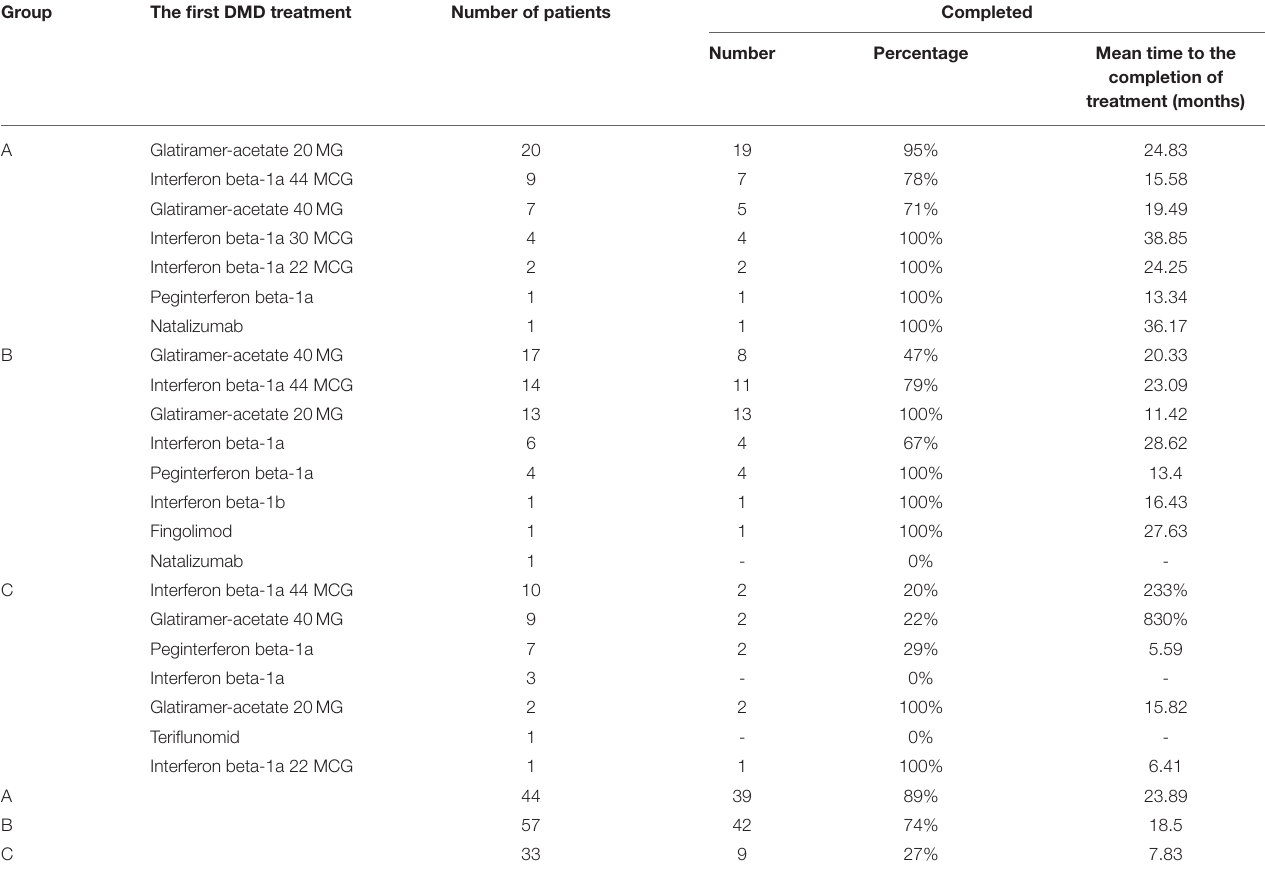
TABLE 4 | Overview of the first DMD treatment for all groups by active molecules.